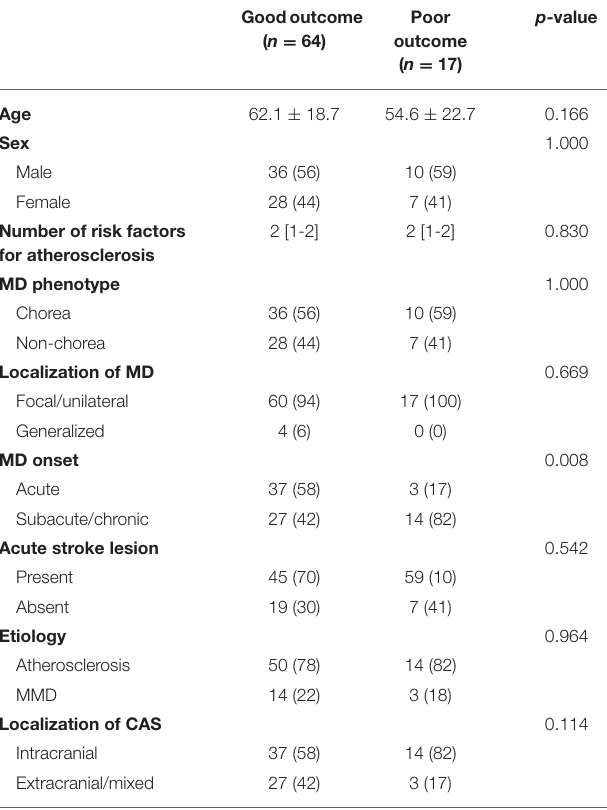
TABLE 2 | Comparison between patients with atherosclerosis ( n = 64) and moyamoya disease ( n = 17). Atherosclerosis ( n = 64)